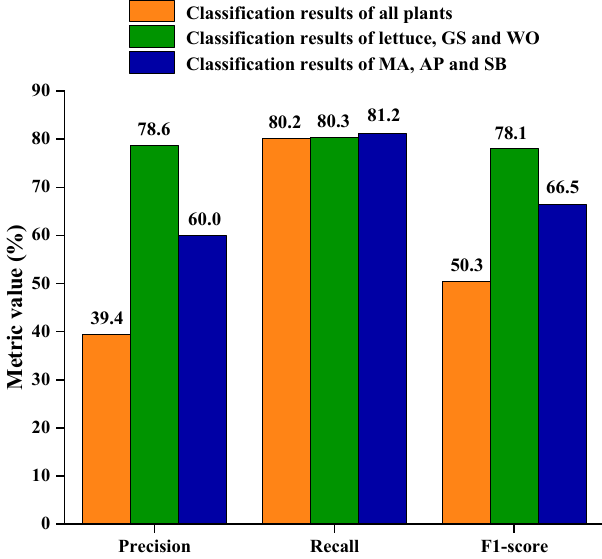
Figure 9. Comparison of SVM modeling results using different datasets.